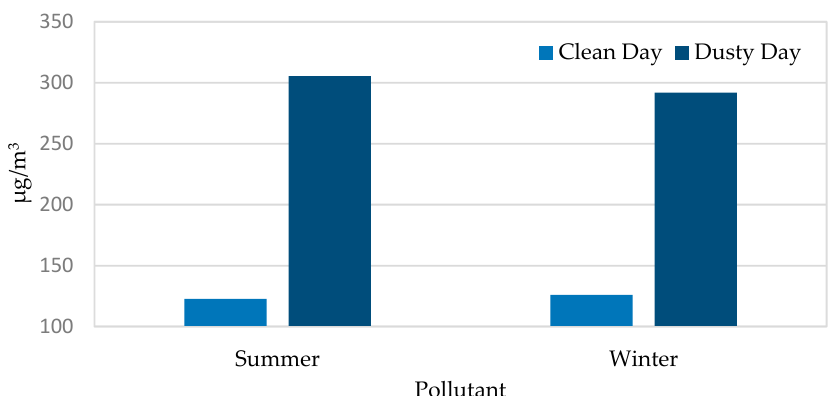
Figure 15. The aerosols for clean and polluted days.